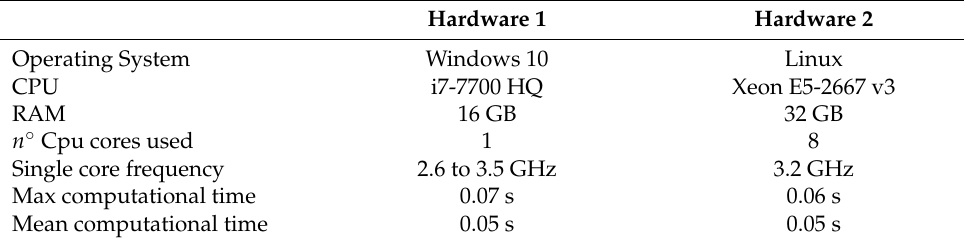
Table 2. Hardware